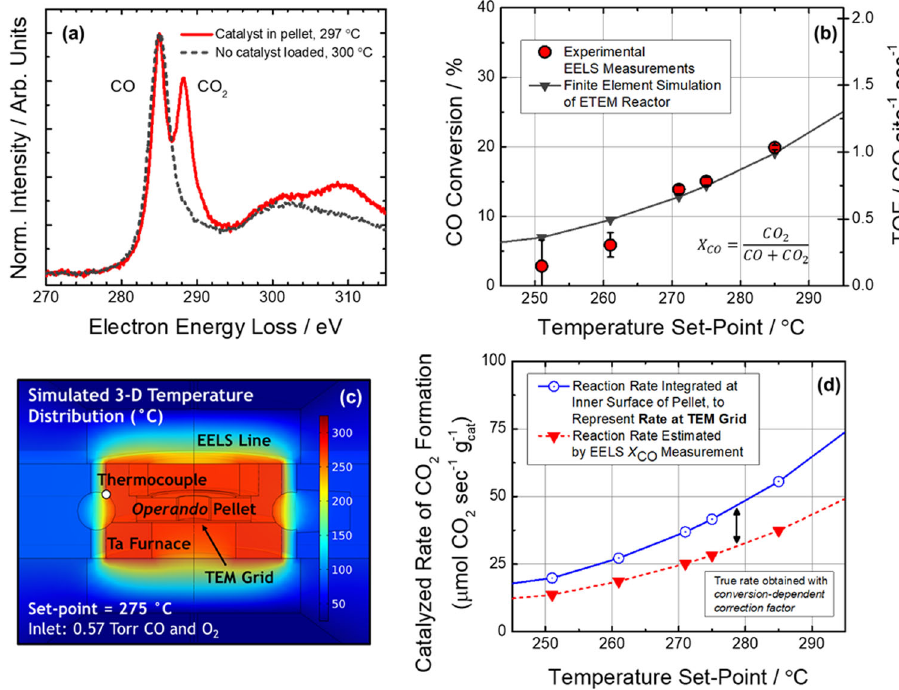
Fig. 3 Detection and quanti fi cation of in situ CO conversion and catalytic reaction rate in the ETEM reactor. a A set of background-subtracted electron energy-loss spectra taken from the gas atmosphere around the reactor demonstrates that the conversion of CO (C π * peak at 285 eV) into CO 2 (C π * peak at 288.3 eV) is attributed unambiguously to the Pt/CeO 2 catalyst, not the reactor. b The CO conversion detected with EELS during the operando ETEM experiment was quanti fi ed and plotted as a function of temperature (red circles). The solid gray curve displays the CO conversion evaluated under nominally identical conditions within a fi nite element simulation of the ETEM reactor. Error bars are given as the standard deviation in fi ve consecutive measurements. c The simulated temperature distribution in the model reactor is plotted for a furnace set point of 275 °C. d Analysis of the catalyzed rate of product formation in the model, which provides a conversion-dependent correction factor for quantitatively determining the catalytic reaction rate from the in situ conversion